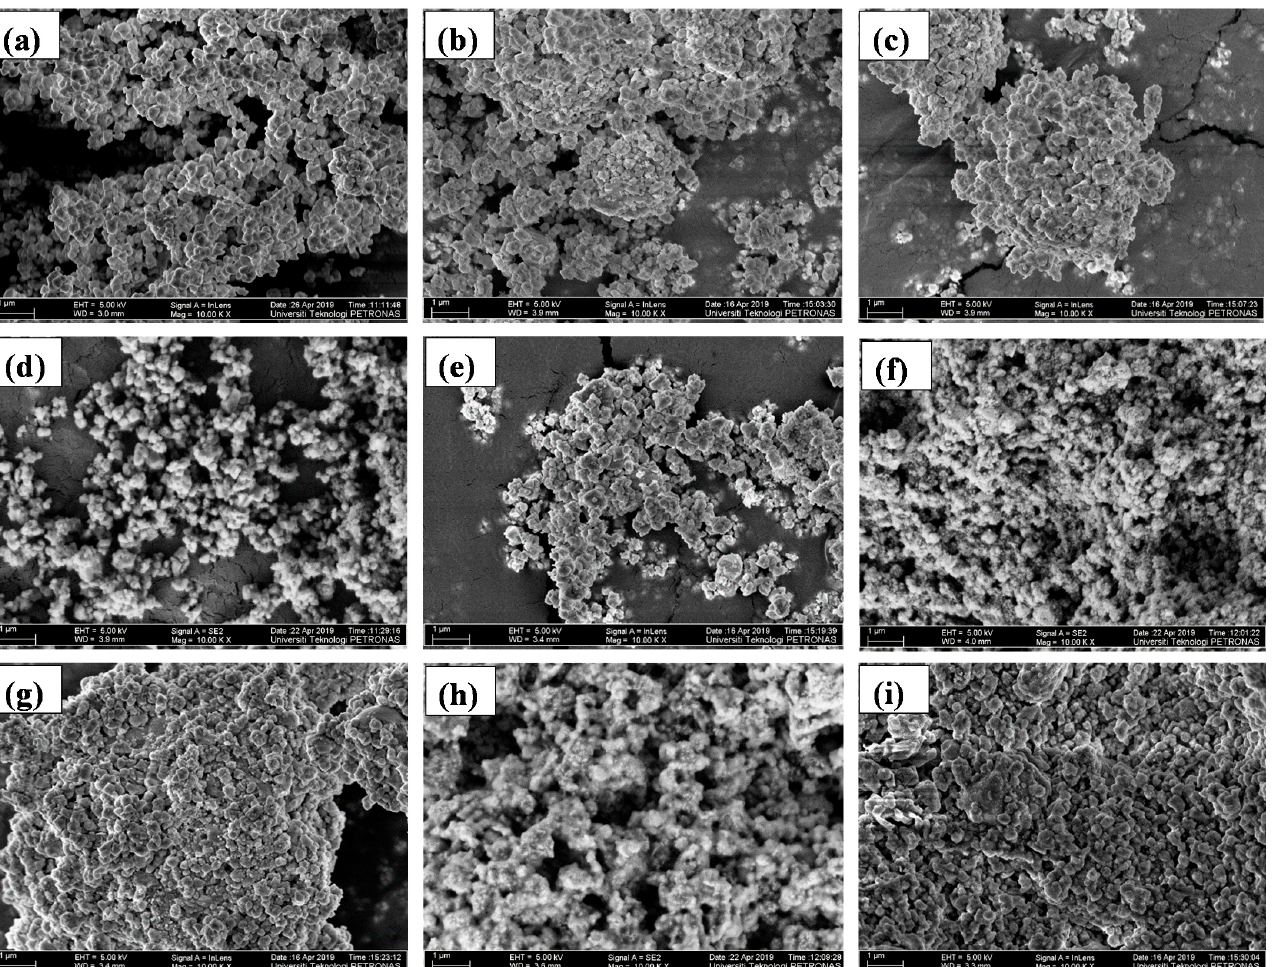
Figure 2. FESEM images, EDX spectra, and dot mapping images of all the synthesized catalysts: ( a ) ZrO 2 , ( b ) 10%Ni/ZrO 2 _WI, ( c ) 10%Ni/ZrO 2 _Us, ( d ) 10%Ni-0.5%Ca/ZrO 2 _Us, ( e ) 10%Ni-0.5%Ca/ZrO 2 _WI, ( f ) 10%Ni- 3%Ca/ZrO 2 _Us, ( g ) 10%Ni-3%Ca/ZrO 2 _WI, ( h ) 10%Ni-5%Ca/ZrO 2_ Us, and ( i ) 10%Ni-5%Ca/ZrO 2_ WI.